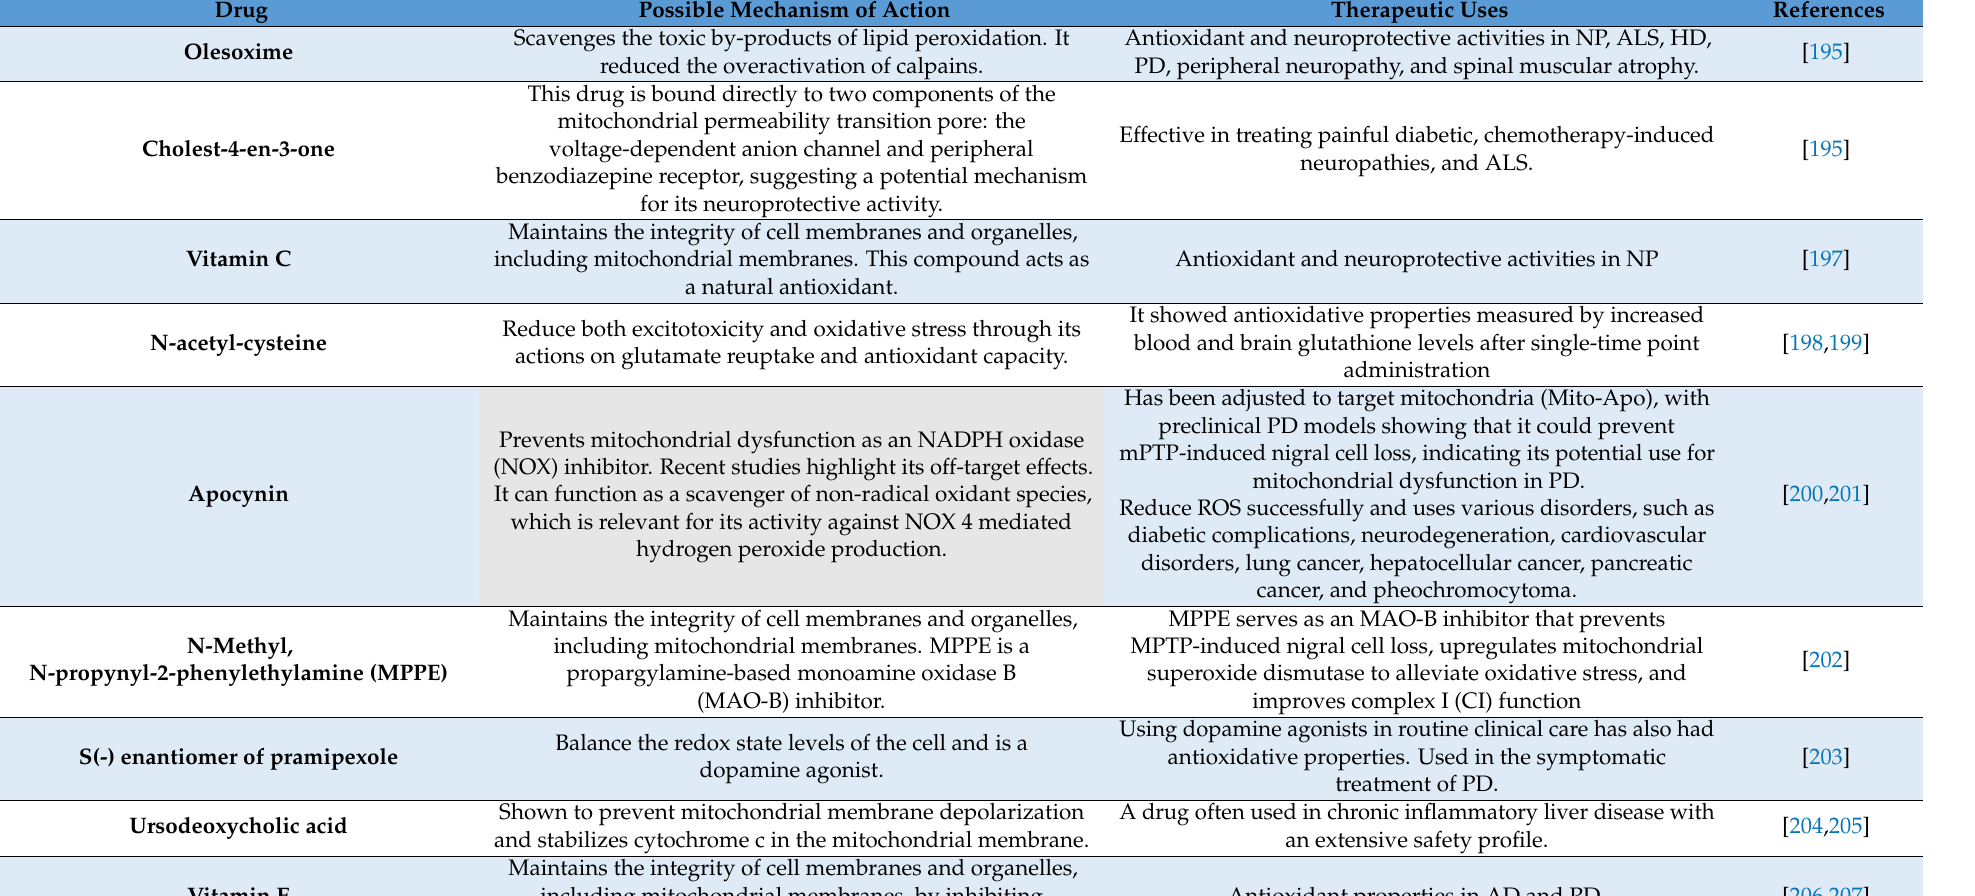
Table 1. Some drugs targeting mitochondrial